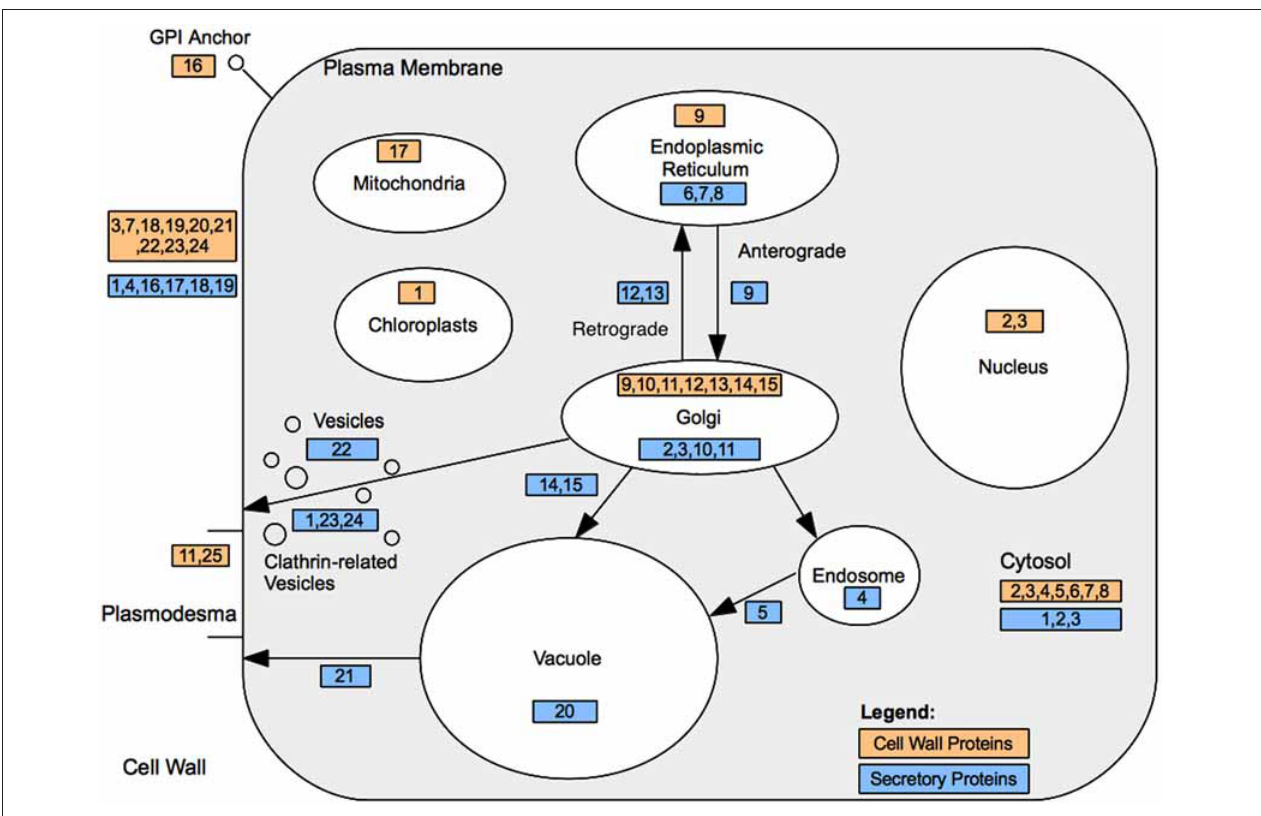
FIGURE 4 | Cell wall and secretory protein localization. Cell wall associated protein locations are denoted by their ID within light orange shaded rectangles. Endomembrane/secretory pathway associated proteins are represented by their ID within light blue rectangles. Further details are presented in Tables 2 and 3